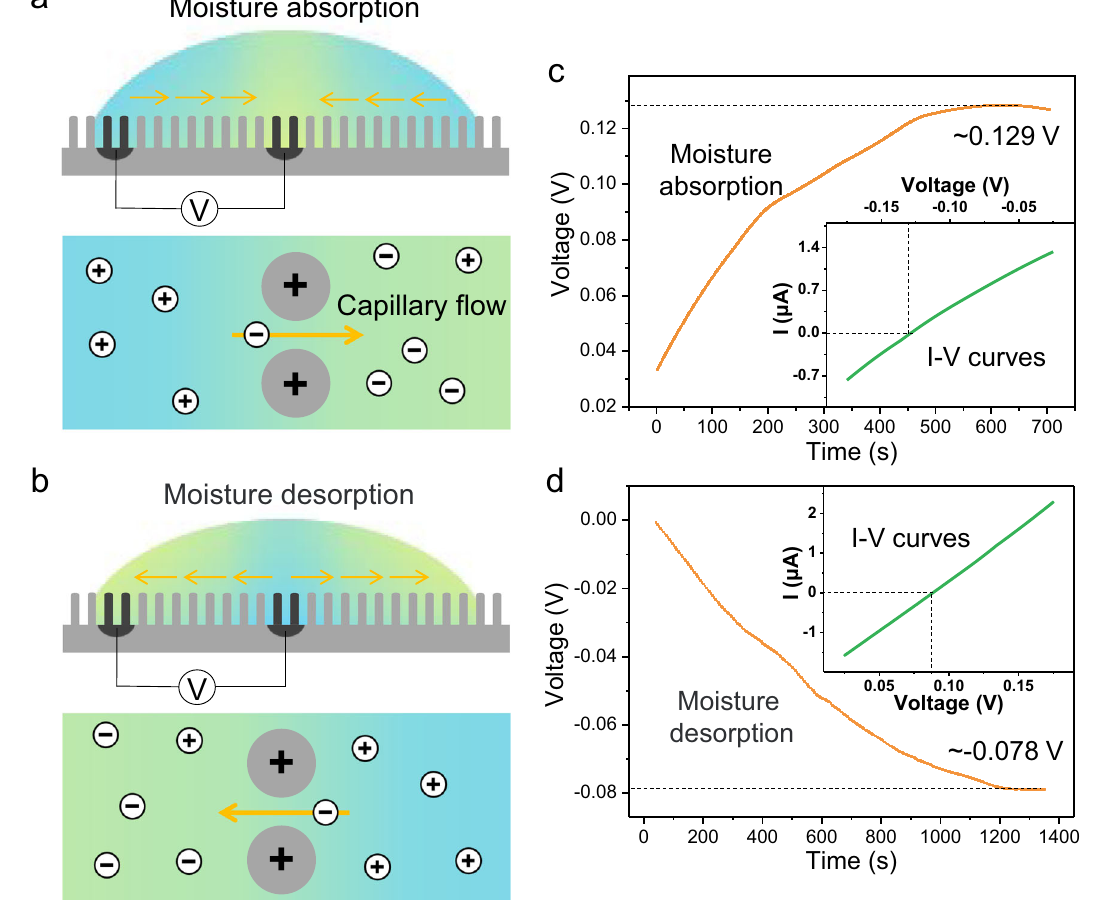
Fig. 2 Moisture absorption/desorption induced power generation under constant temperature and humidity. a , b Schematics showing the proposed process of moisture absorption/desorption caused directional inward/outward fl ow and the fl ow induced potential difference. c , d V OC of low-/high-water- content IL drop exposed to constant air RH of ~40% at 25 °C. Inset was the I – V